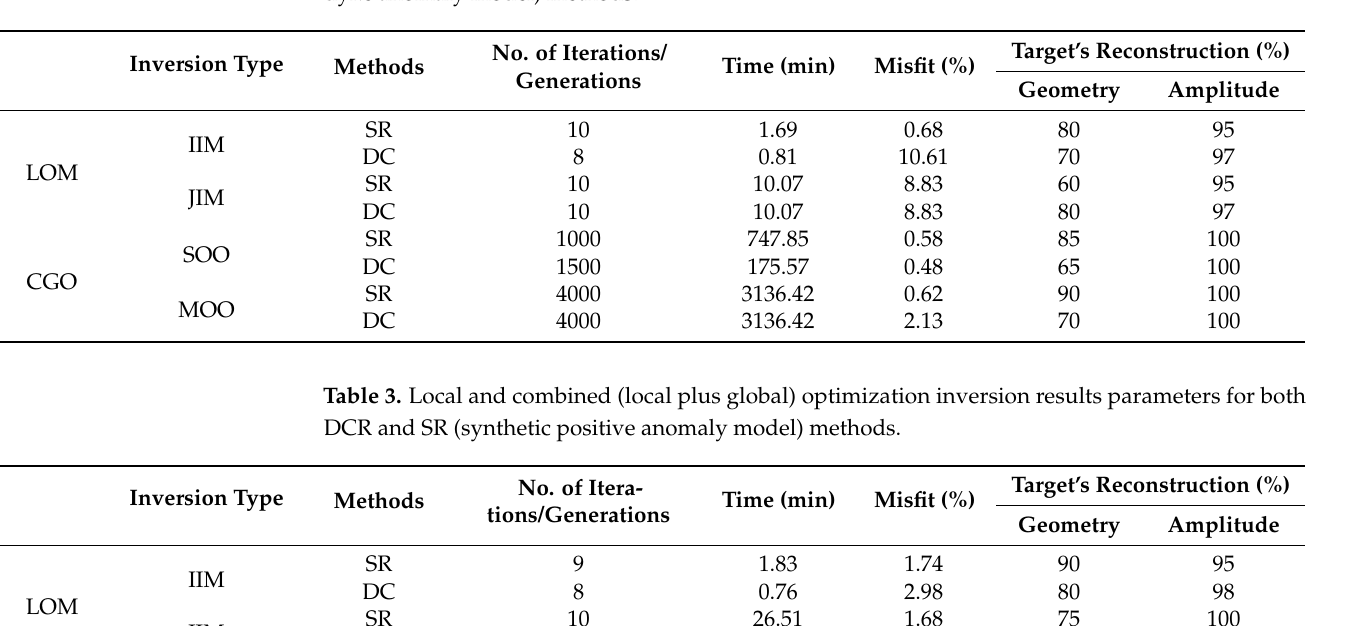
Table 2. Local and global optimization inversion results parameter for both DCR and SR (synthetic dyke anomaly model) methods.